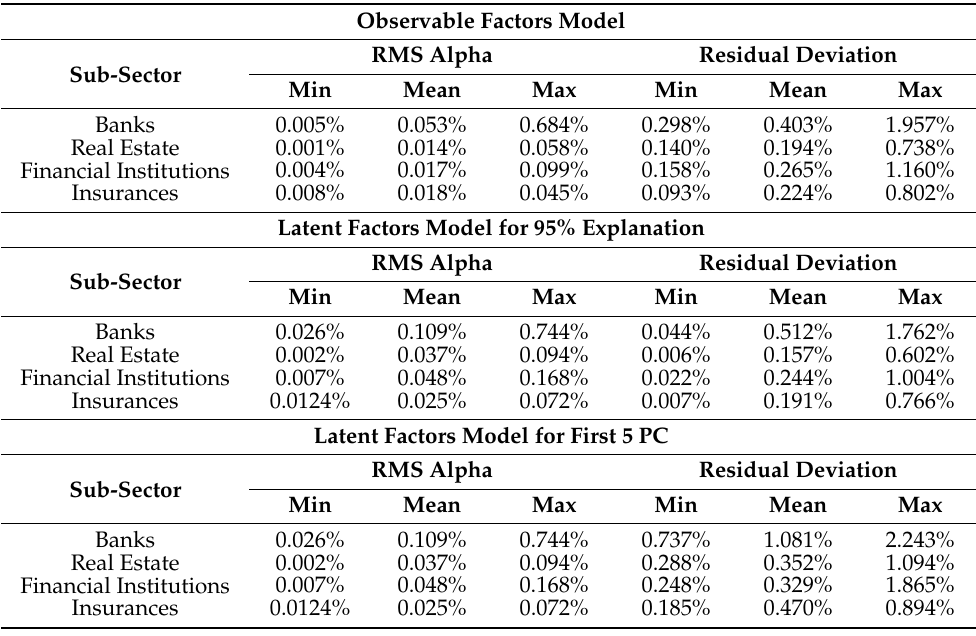
Table 5. Results of the comparison of the latent and observable factor